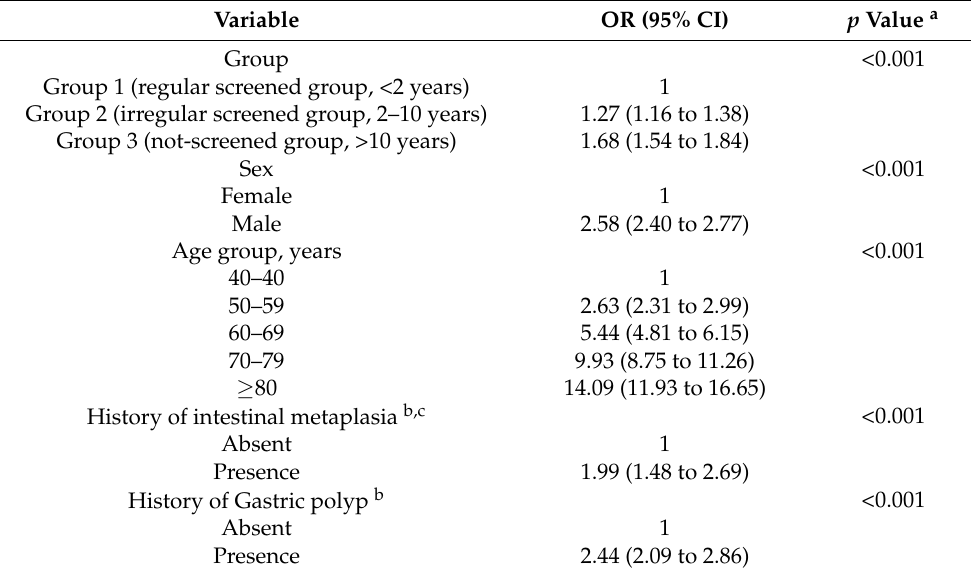
Table 3. Multivariable logistic regression analysis of risk factors associated with interval cancer detection in the Korean National Cancer Screening Program for gastric